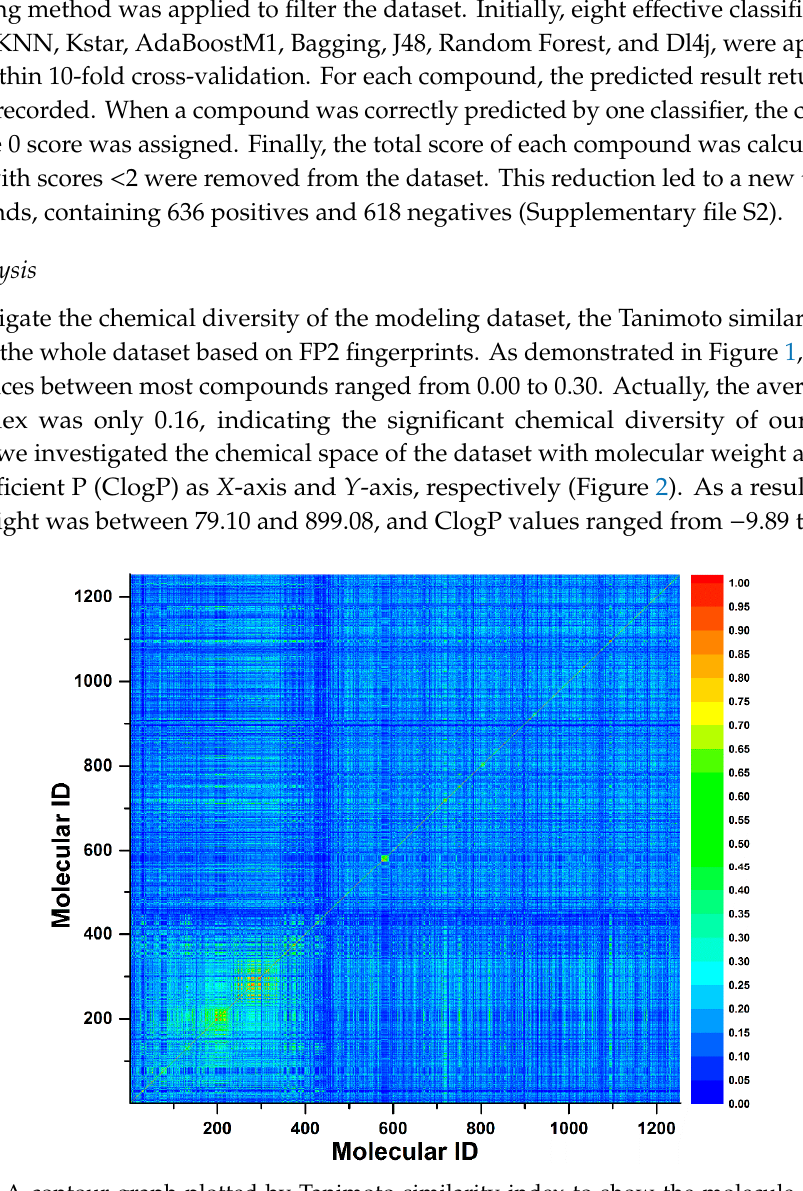
Figure 1. A contour graph plotted by Tanimoto similarity index to show the molecule similarity. The Tanimoto similarity index was calculated by FP2 fingerprint.